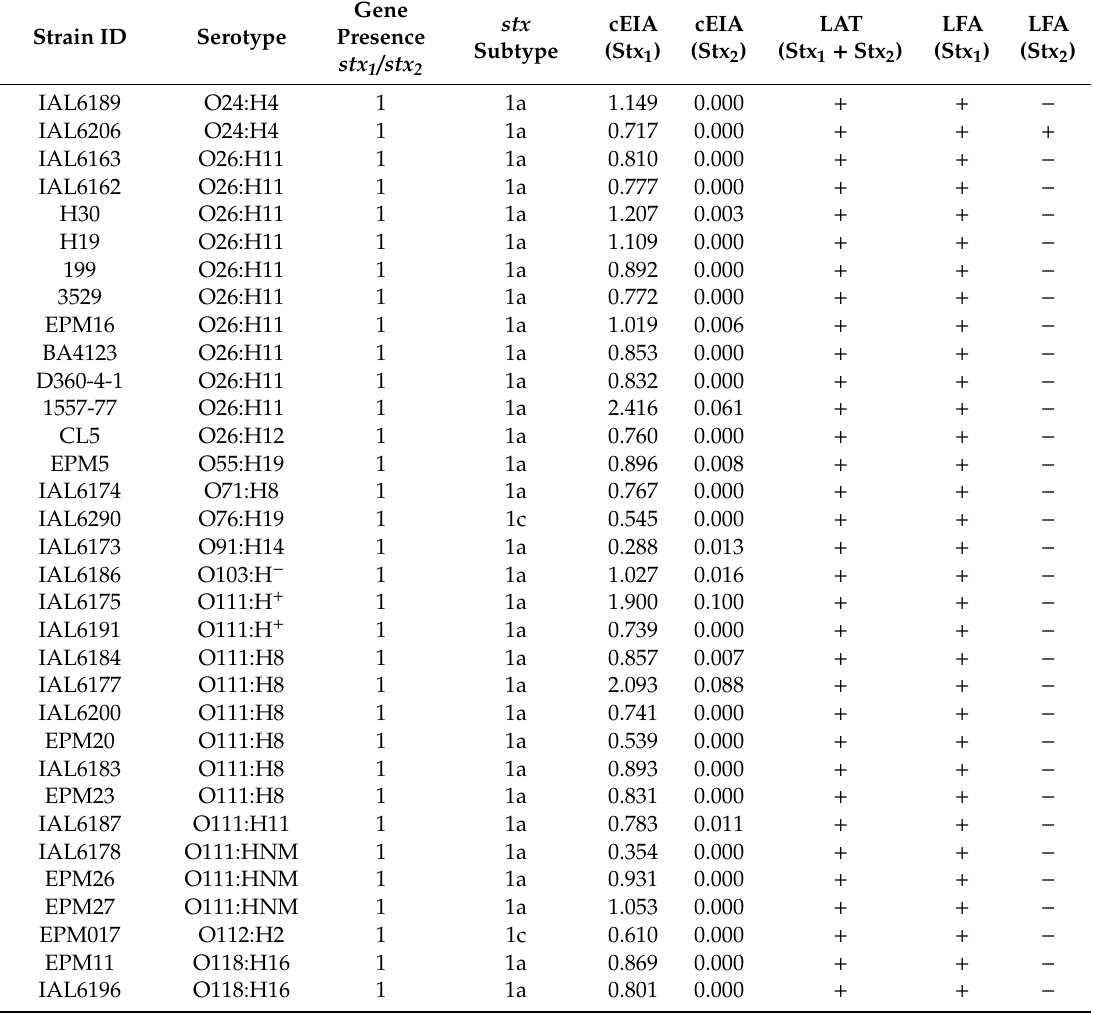
Table 1. Shiga toxin-producing E. coli (STEC) strains immunoassay